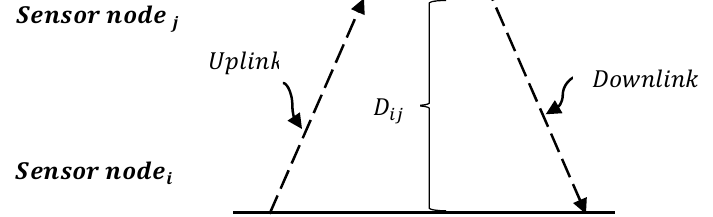
Figure 2. Two-way time message exchange between node 𝑖 and node 𝑗 .